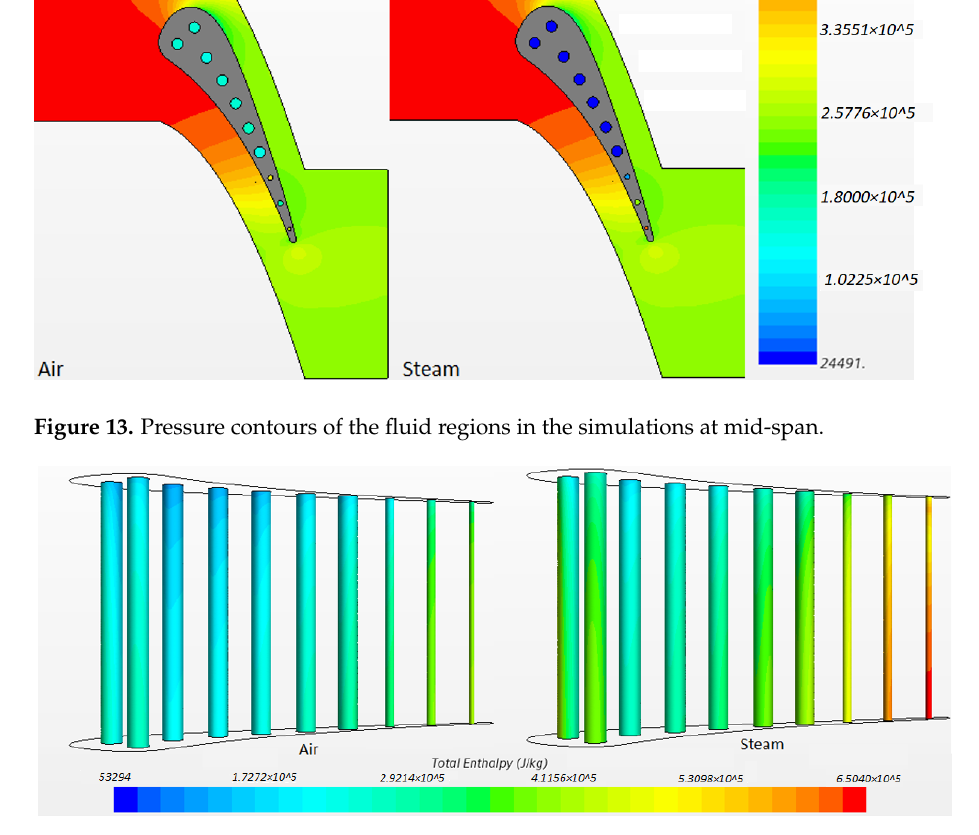
Figure 14. Comparison of the total enthalpy contours in the cooling channels. Colour bar is displaying the different enthalpy levels present in the